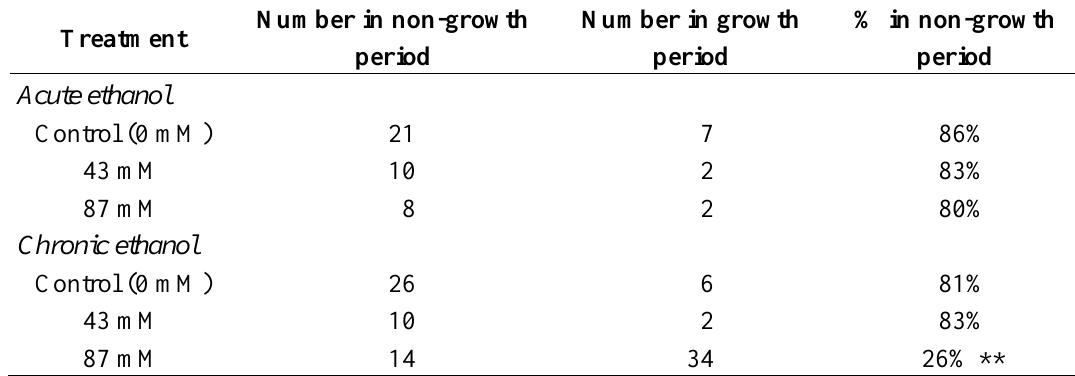
Table 1. The percent of wave-displaying growth cones which are in periods of non-growth.